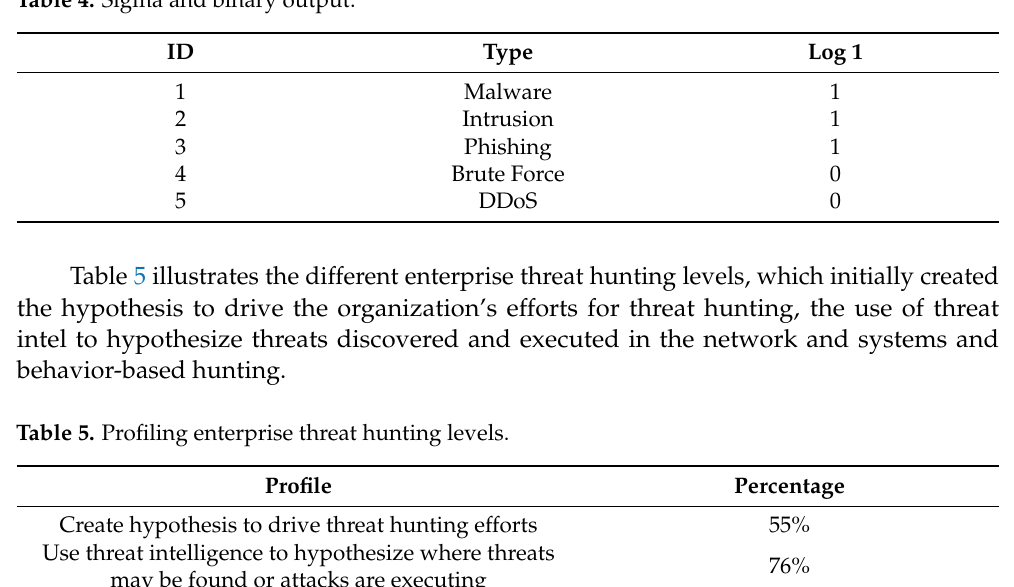
Table 4. Sigma and binary output.